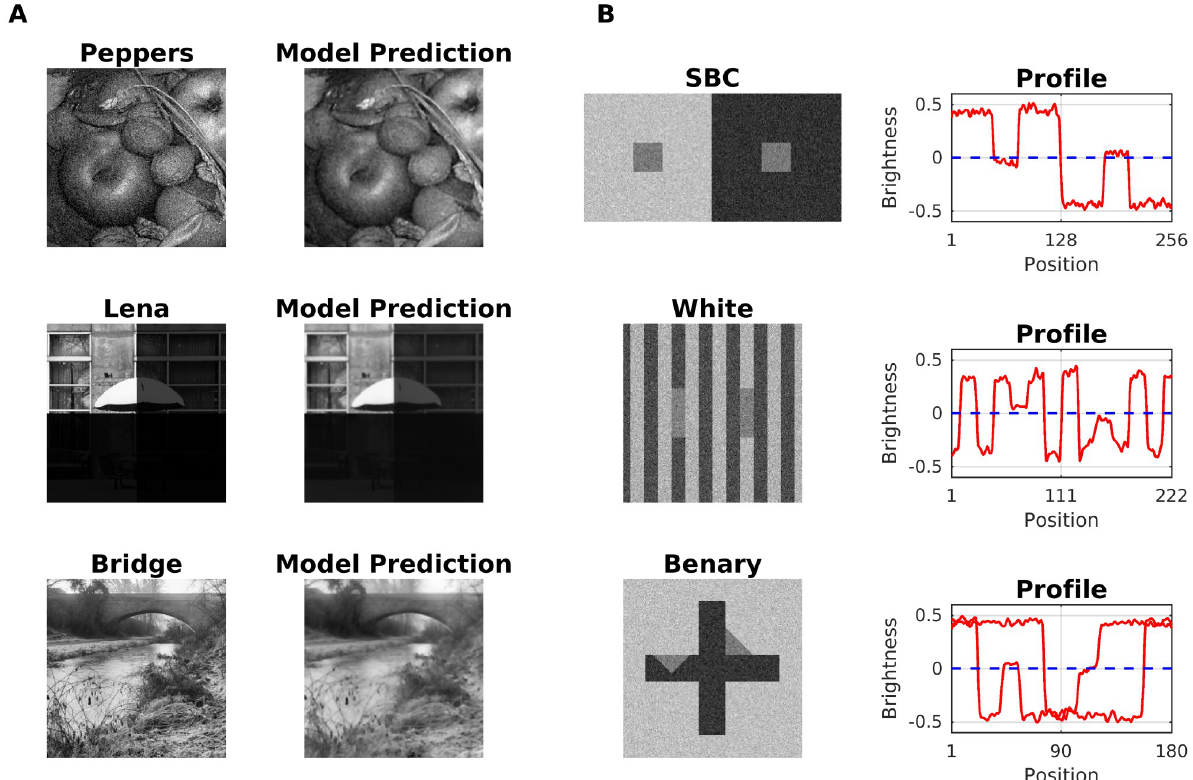
Fig 22. Real-world image processing. (A) Top: Fruits image with additive white noise (SNR = 2.6266dB and PSNR = 8.9813dB) along with the corresponding model output (SNR = 5.4682db and PSNR = 11.8228dB); The models capacity for noise removal is worse than an algorithm based on Tikhonov regularization (SNR = 8.30dB and PSNR = 14.65dB; [111]. Middle: A high-dynamic-range version of a real image (where dynamic range of each quadrant decreases clockwise by one order of magnitude) and model output; the dynamic range of the input is 1, and that of the output is 0.9596. Bottom: Bridge image alongside with corresponding model output (SNR = 6.1084dB and PSNR = 13.6201dB). (B) Top: Simultaneous Brightness Contrast display with additive white noise and corresponding brightness profile (red line) as predicted by the model. The dashed line indicates the gray level of the gray squares. Middle: White Effect. Bottom: Benary